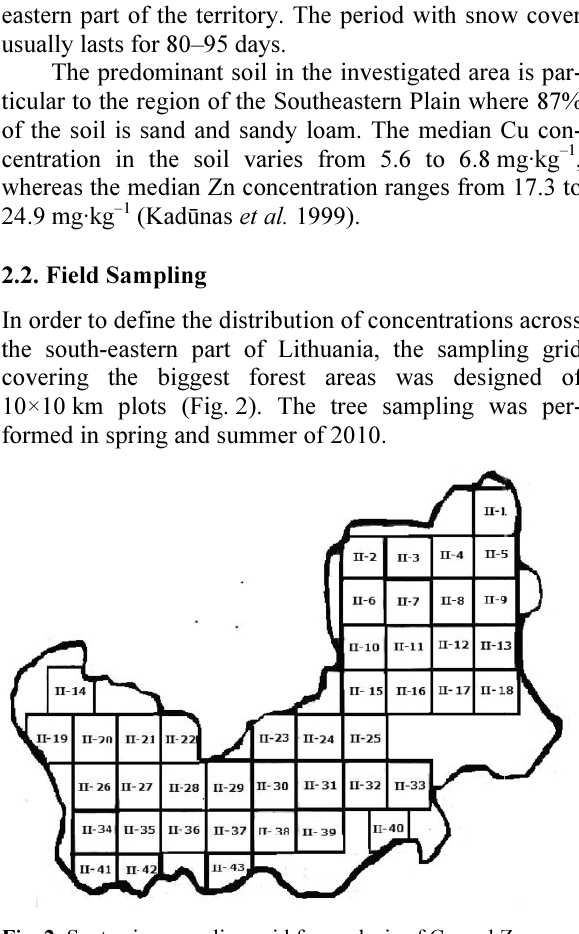
Fig. 2. Scots pine sampling grid for analysis of Cu and Zn, 10×10 km